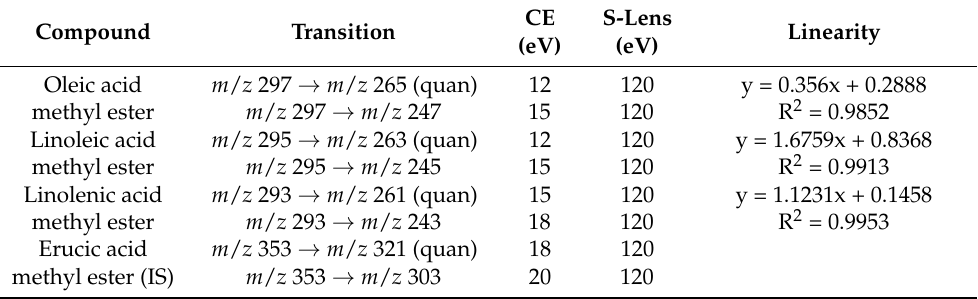
Table 1. Selected MRM transitions, instrumental parameters and calibration curve equations.